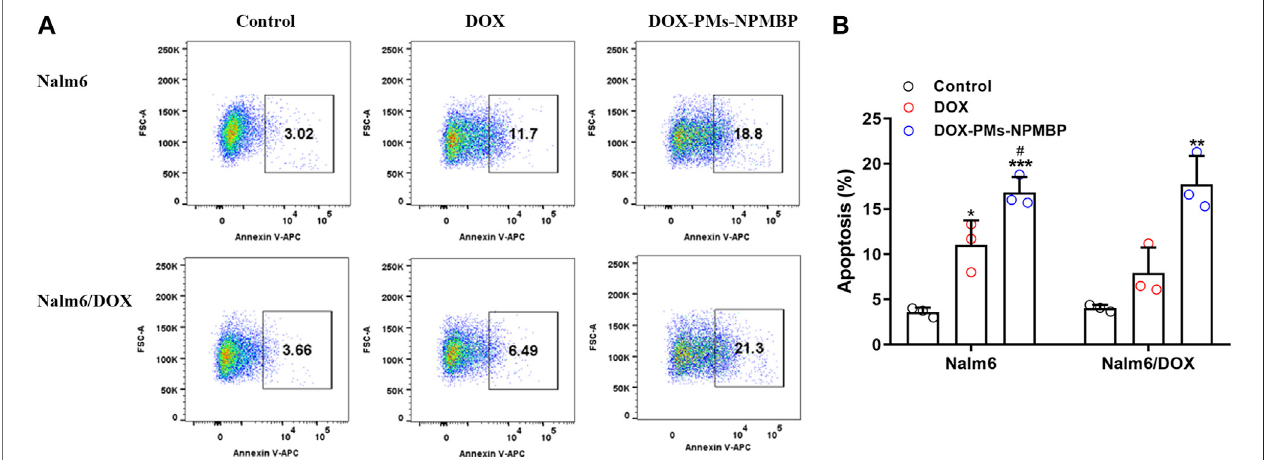
FIGURE 2 | DOX-PMs-NPMBP induces apoptosis in Nalm6/DOX cells. Nalm6/DOX cells were incubated with DOX or DOX-PMs-NPMBP for 24 h. Frequency of cells undergoing apoptosis was stained with Annexin V-APC and analyzed by fl ow cytometry. (A) Representative fl ow-cytograms of Annexin V + cells in each groups